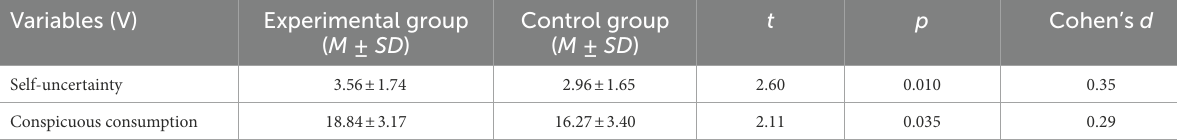
TABLE 1 The effect of interpersonal self-uncertainty on conspicuous consumption in experiment 4.